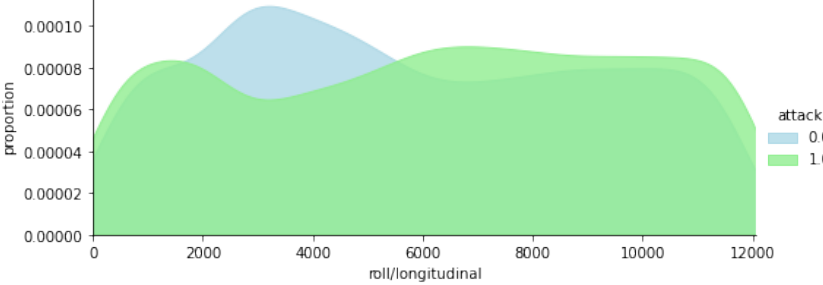
Figure 8. Numerical feature analysis of attacked transverse and pitch motions.